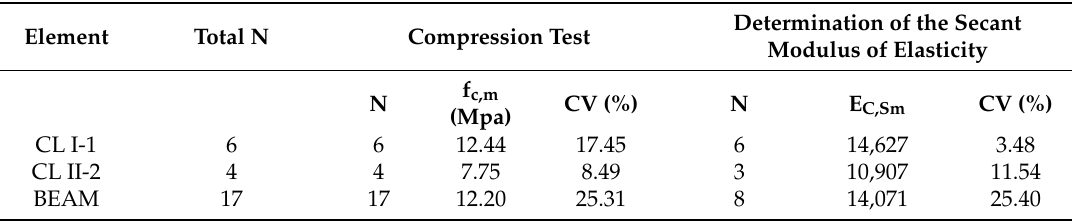
Table 1. Results from compression tests.